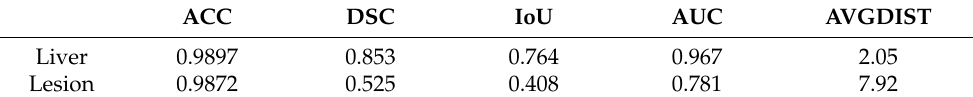
Table 2. Accuracy of liver and lesion identification after training with the default LiTS database.